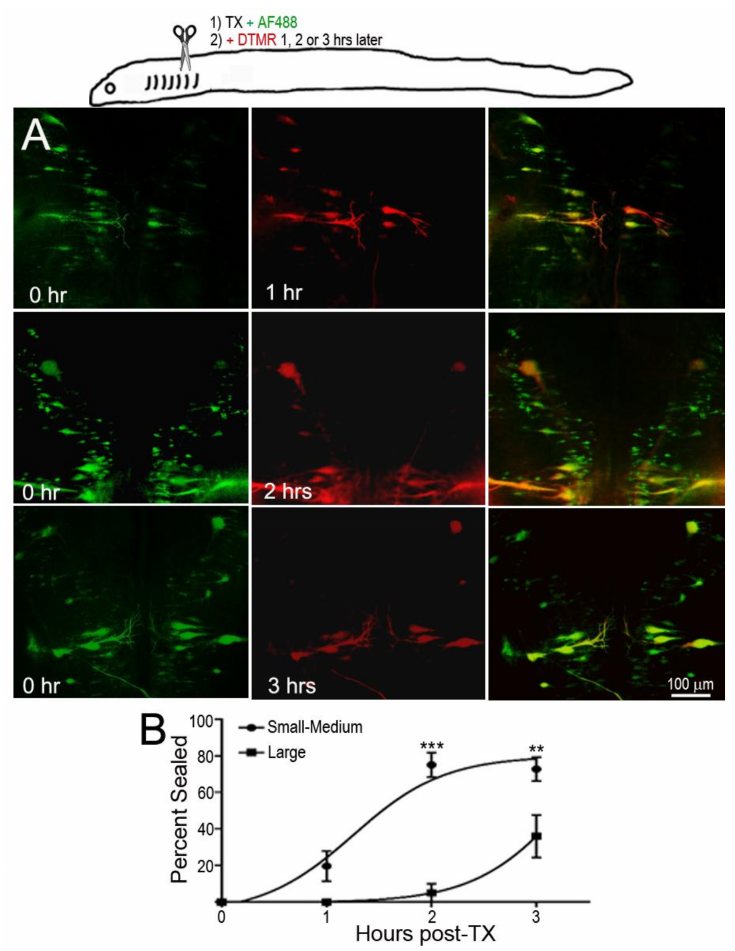
Figure 2. Delayed axon resealing of large neurons. RS neurons were labeled retrogradely by D-AF488 applied to fresh spinal cords transections (TX) made at the level of the 5th gill in three animals. DTMR was applied to the same site 1–3 h later, as diagrammed in the drawing at the top. ( A ) Left column , RS neurons in three different animals labeled by D-AF488; middle column , in the same three brains, RS neurons labeled by DTMR applied at 1, 2, or 3 h post-TX, as indicated; right column , overlay images show that the axons of small RS neurons resealed as early as at 1 h post-TX, but the axons of large RS neurons remained open until 3 h post-TX; ( B ) non-linear regression curves of % of axons sealed. “Large” neurons are identified RS neurons with cross-sectional areas ≥ 2000 µ m 2 ; the other neurons are “Small–Medium”. For the Small–Medium neurons, r = 0.85; for the Large neurons, r = 0.92. For the differences between the Small–Medium and the Large groups, ** p = 0.0032, *** p <